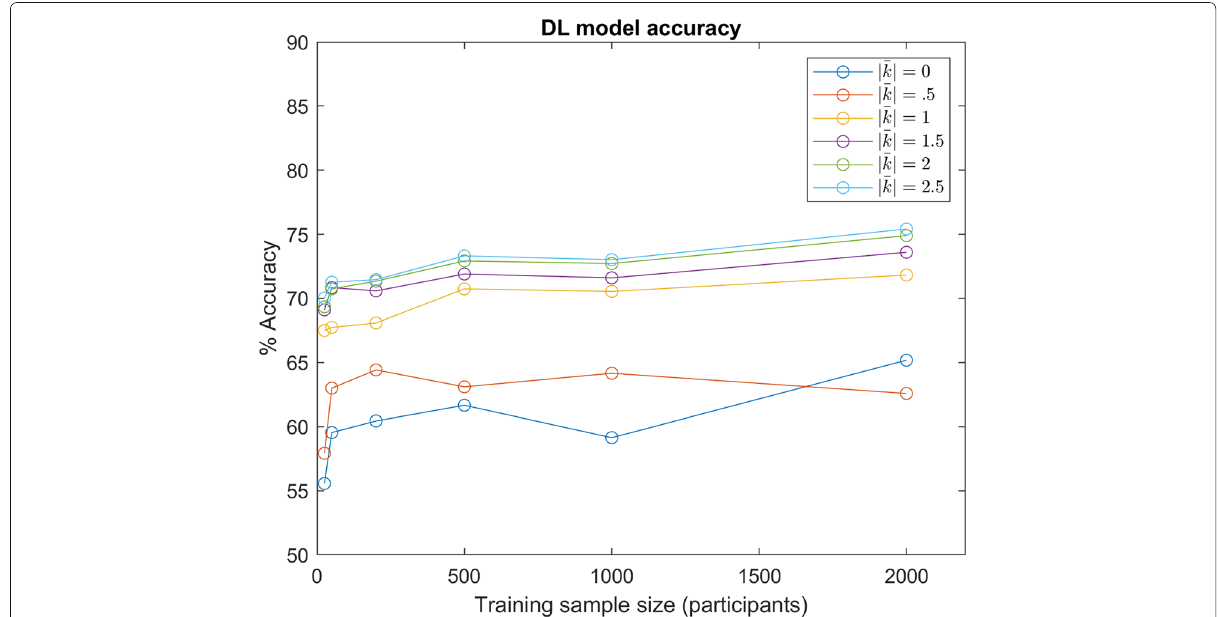
Fig. 9 DL Accuracy: DL model predictive accuracy with different sample sizes and underlying distributions of w . Various distributions for w are denoted by the approximate average of absolute shape factors k (